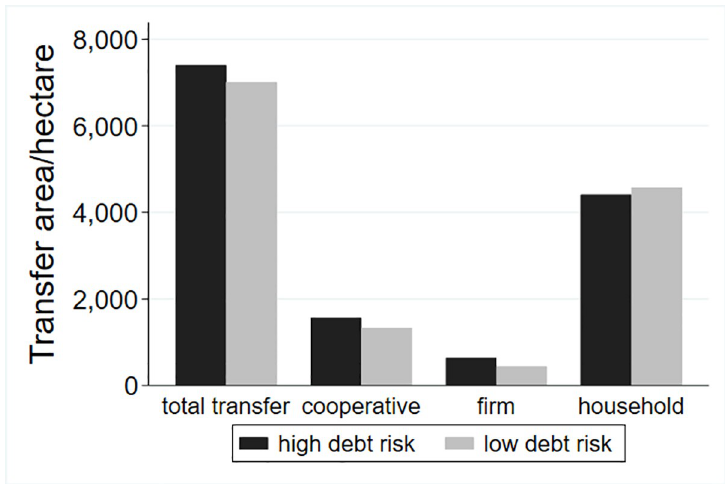
Fig 3. Land transfer scale in the regions with different ratio of debt with per capita